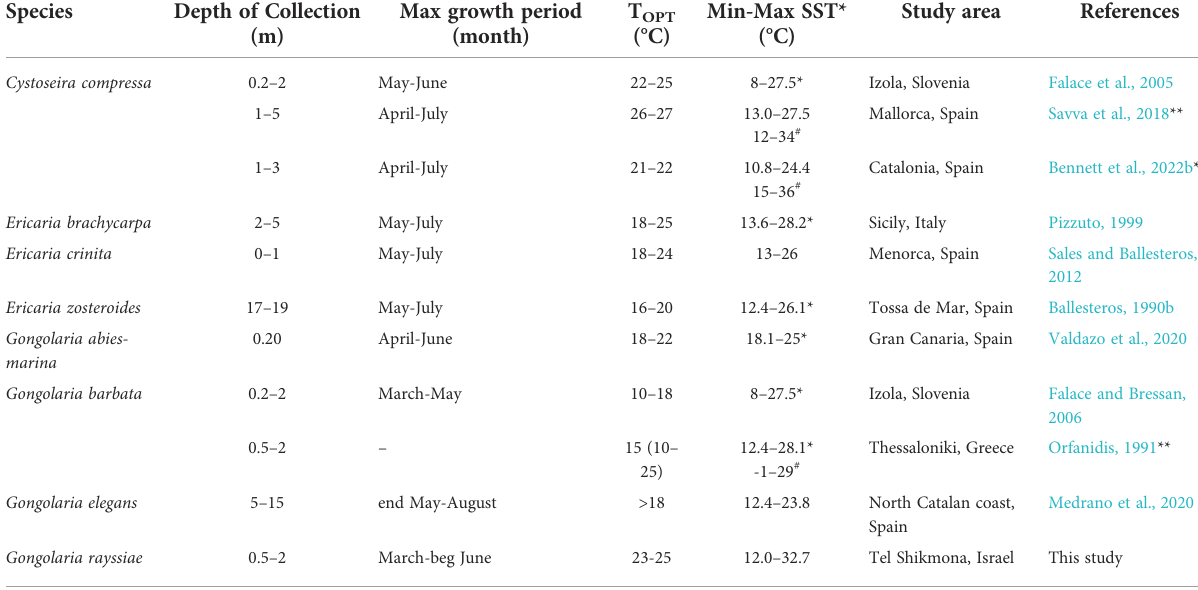
Species Depth of Collection